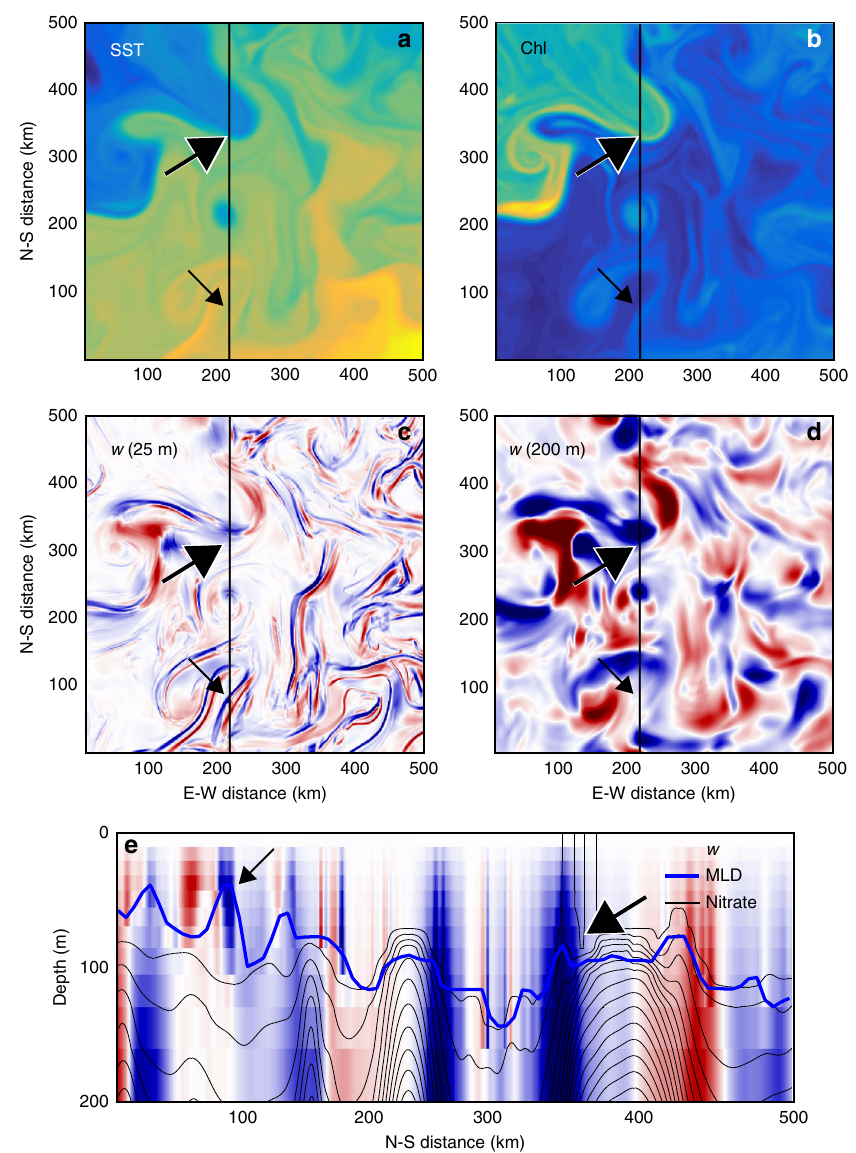
Fig. 5 Submesoscale vertical advection at fronts. a Sea surface temperature (SST), b sea surface chlorophyll (Chl), and c , d vertical velocities ( w : red = upwelling, blue = downwelling) c in the surface mixed-layer (at 25 m depth), and d below (at 200 m depth) in a 500 km × 500 km box from a larger ocean general circulation model representing the Gulf Stream region (the full model domain is shown in Box 3; these data come from the black square region). e A vertical section taken along the black line of a – d showing vertical velocity (blue-red), with nutrient contours (black lines) and mixed-layer depth (heavy blue lines) overlaid. Vertical velocities associated with the persistent front (meandering Gulf Stream, large black arrows) extend from the surface and penetrate below the nutricline (delinated as the fi rst nutrient contour). The near-surface vertical velocity fi eld also exhibits thin, elongated submesoscale structures, located at submesoscale temperature fronts (small black arrows). Unlike the vertical velocities associated with the persistent front, the vertical velocities at submesoscale fronts do not extend much below the surface mixed layer, and do not always reach the nutricline. This results in a response of surface phytoplankton at the deep persistent front (yellow color show maximum phytoplankton concentrations at the front, large black arrows) but not at the shallow submesoscale front (small black arrows). Adapted from Lévy et al.